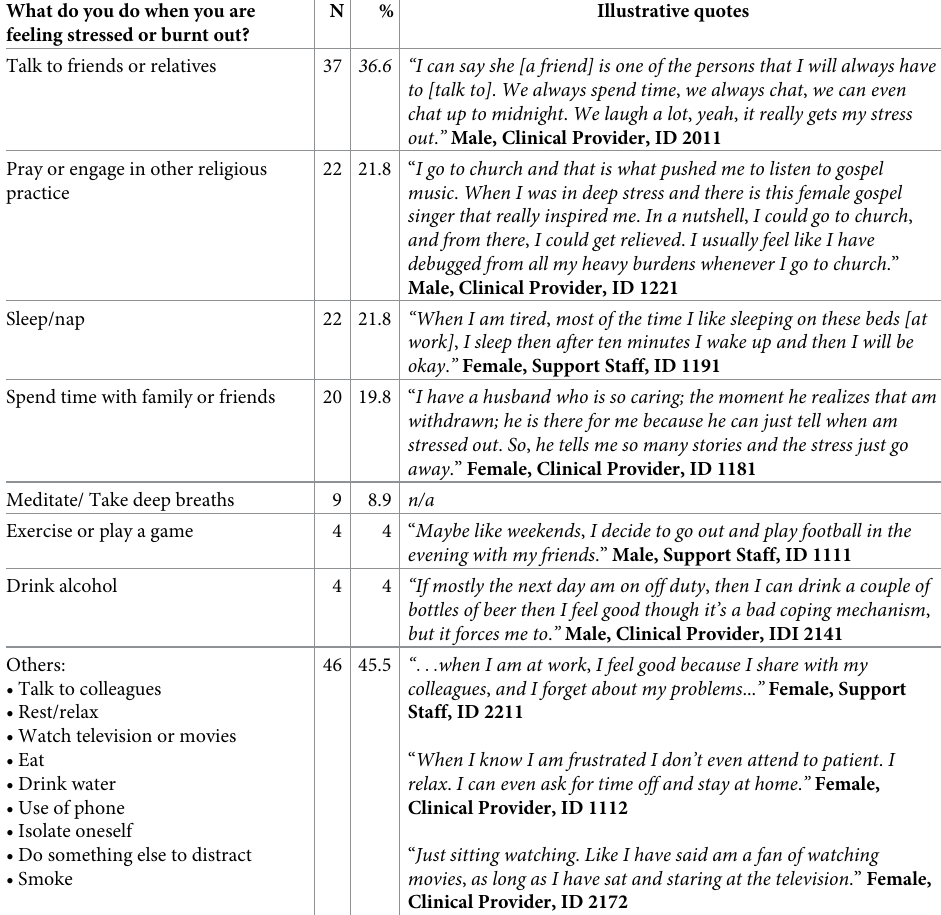
Table 3. Coping mechanisms with illustrative